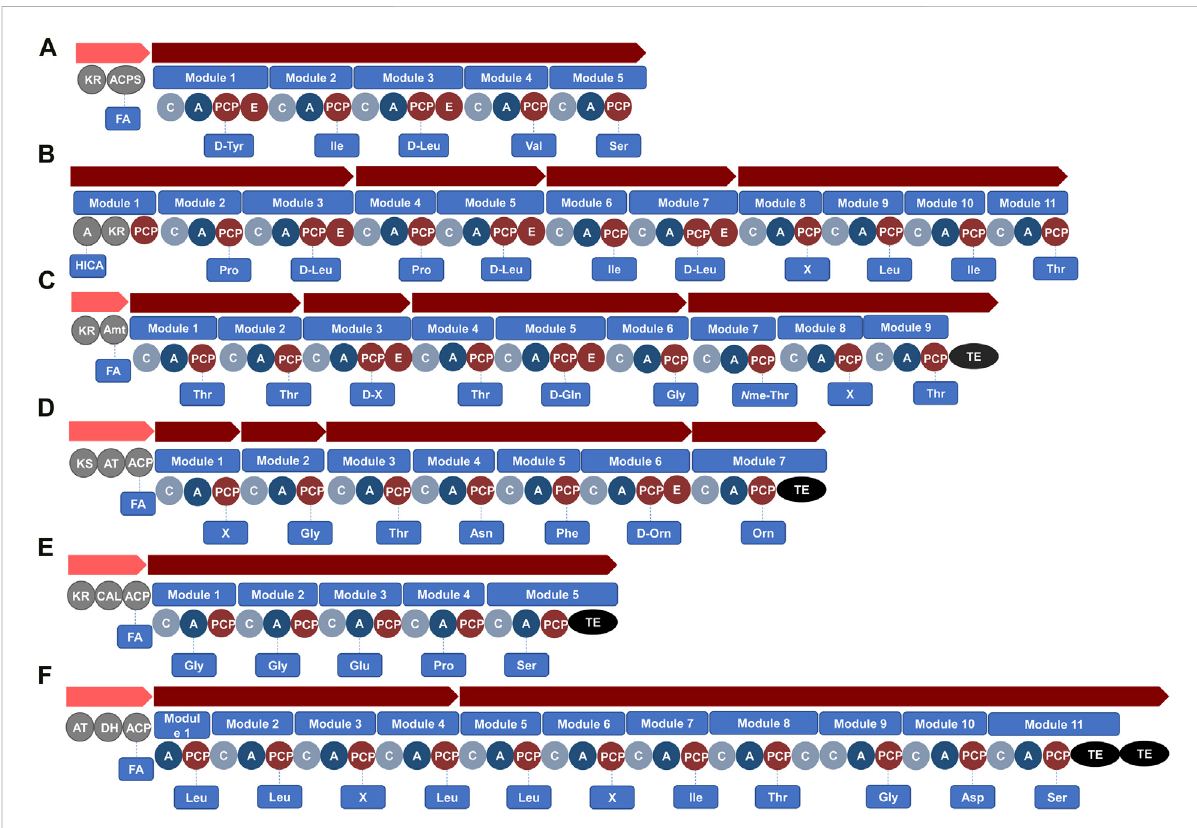
FIGURE 4 Unknown bacterial BGCs identi fi ed using antiSMASH in the genomes of (A) S. fonticola R28 (NCBI accession no. CP072742.1), (B) B. laterosporus LMG15441(NCBIaccessionno.CP007806.1), (C) B.mayonis BDU8(NCBIaccessionno.CP013389.1), (D) M.xanthus GH5.1.9c20(NCBI accessionno.CP017170.1), (E) C.fuscus DSM52655(NCBIaccessionno.CP022098.1)and (F) L.gummosus 10.1.1(NCBIaccessionno.CP093547.1). Domains within modules of the gene clusters that encode for PKS or NRPS enzymes include: KR, ketoreductase; KS, ketoacylsynthase; DH, dehydratase; AT, acyl-transferase; ACPS, phosphopantetheinyl transferase; C, condensation; A, adenylation; PCP, peptidyl carrier protein; E, epimerisation; Amt, aminotransferases; ER, enoylreductase; TE, thioesterase. Abbreviations: FA, fatty acid; HICA, α -hydroxy- isocaproic-acid; X, unknown predicted amino